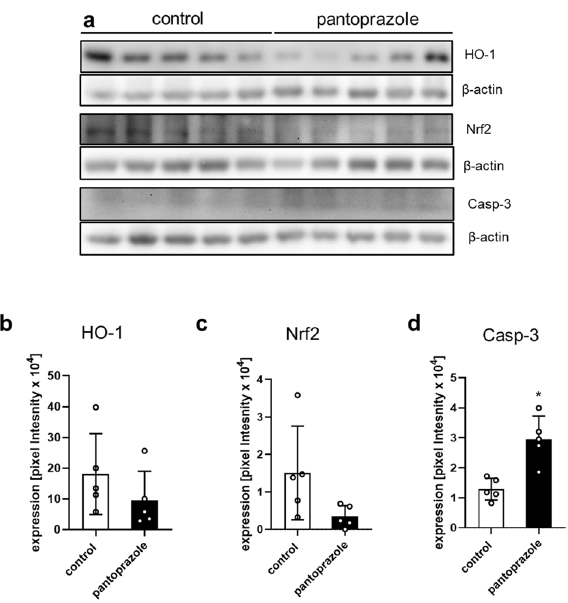
Figure 8. Western blot analysis of mice femora (2). Western blot analysis of the anti-oxidant factors HO-1 ( a , b ) and Nrf2 ( a , c ) and the pro-apoptotic marker Casp-3 ( a , d ) in the callus of controls (white bars) and pantoprazole-treated animals (black bars) at 2 weeks after fracture healing. Means ± SD; n = 5; *p < 0.05 vs.